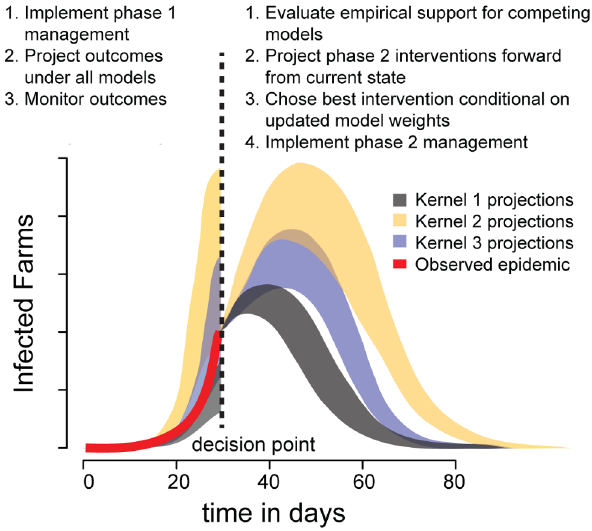
Figure 2. Schematic of the two phases of the AM process (Table 1). Left of the dashed line indicates model projections under the phase 1 management action prior to the first opportunity to update management—colored shading indicates projections of competing models. The red line indicates the observed time series of the epidemic up to the decision point. Right of the dashed line indicates new projections from each model, conditional on the observed epidemic up to the update, from which to assess the alternative management actions.